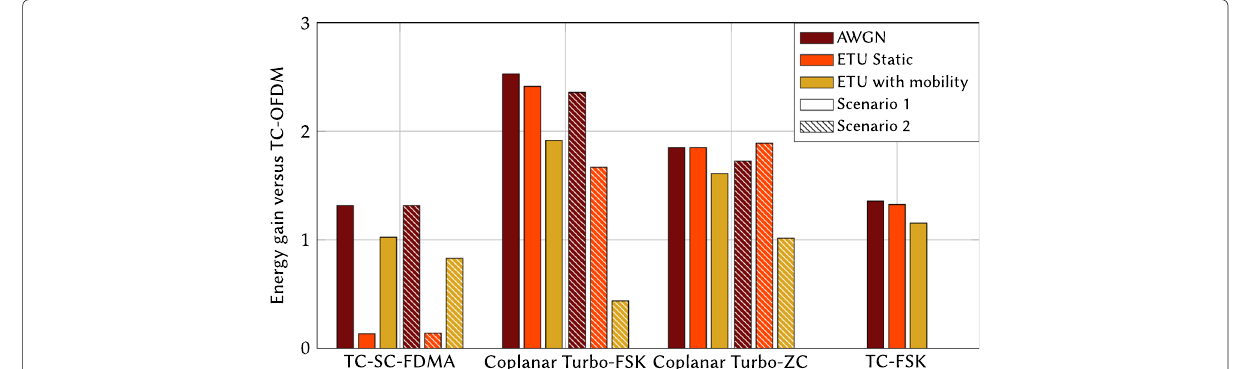
Fig. 9 Energy consumption with respect to the